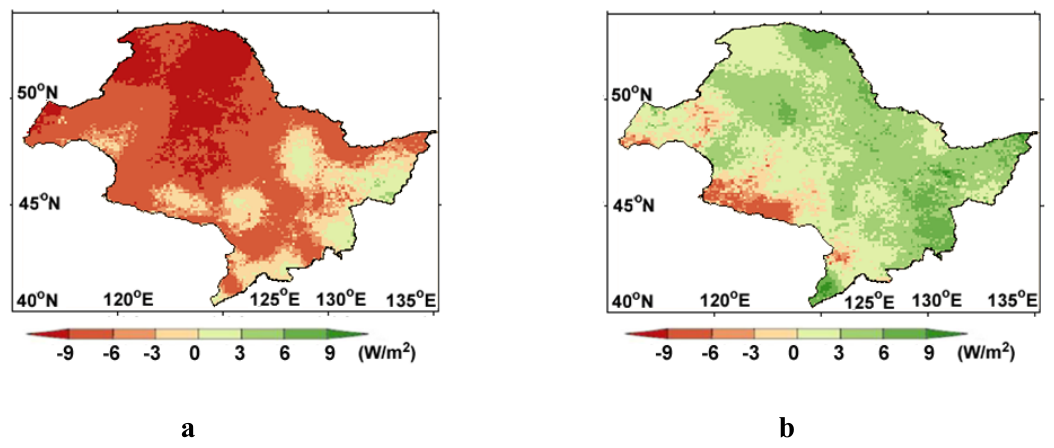
Figure 7. Spatial differences in average annual regional terrestrial ET between the El Niño and La Niña years. ( a ) the difference in annual ET between 1992 and 1991 for El Niño year, ( b ) the difference in annual ET between 2007 and 2006 for La Niña